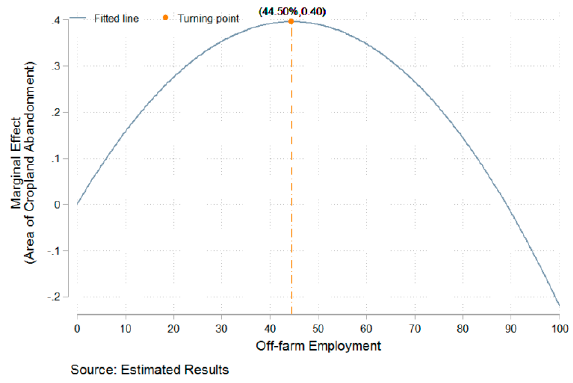
Figure 4. The function of marginal effect of off-farm employment on area.